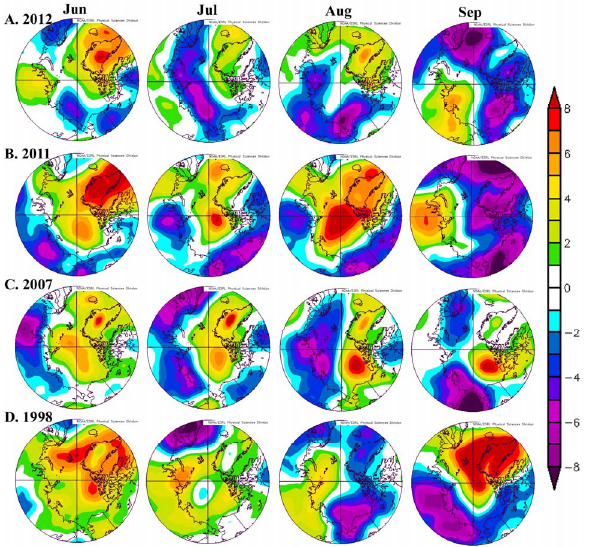
Figure 7. Spatial distribution of NCEP/NCAR mean June to September sea level pressure (SLP; mb) anomalies for 2012, 2011, 2007 and 1998 (A-D). Anomalies calculated with respect to the Fig. 7. Spatial distribution of NCEP/NCAR mean June to Septem- 1981-2010 climatology ber sea level pressure (SLP; mb) anomalies for 2012, 2011, 2007 and 1998 (A–D) . Anomalies calculated with respect to the 1981– 2010 climatology.